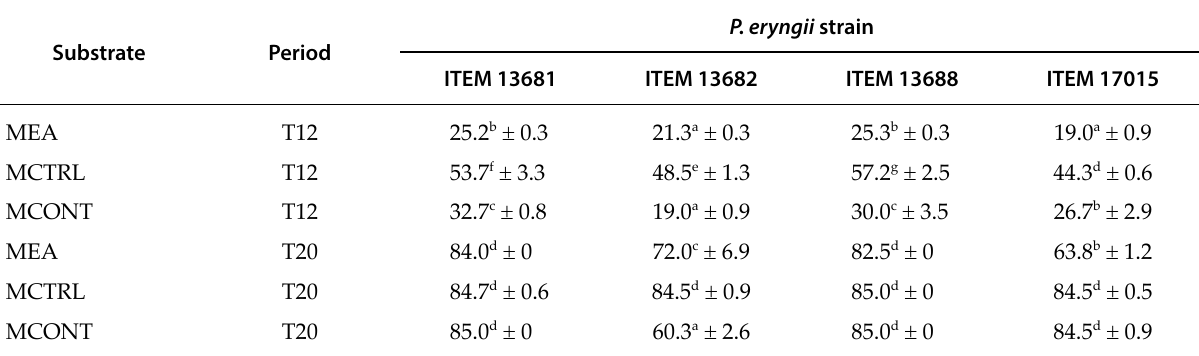
Table 1. Average (± SD*) of 4 P. eryngii strain colony diameters grown on different substrates